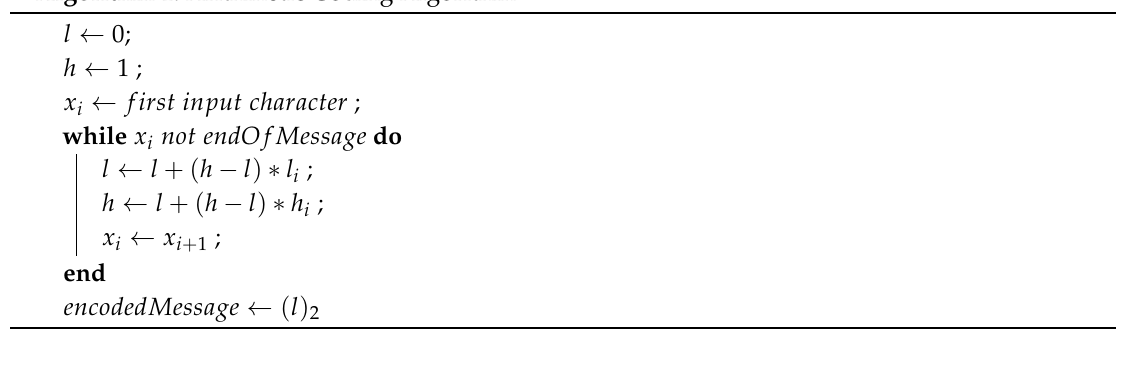
Algorithm 1: Arithmetic Coding Algorithm